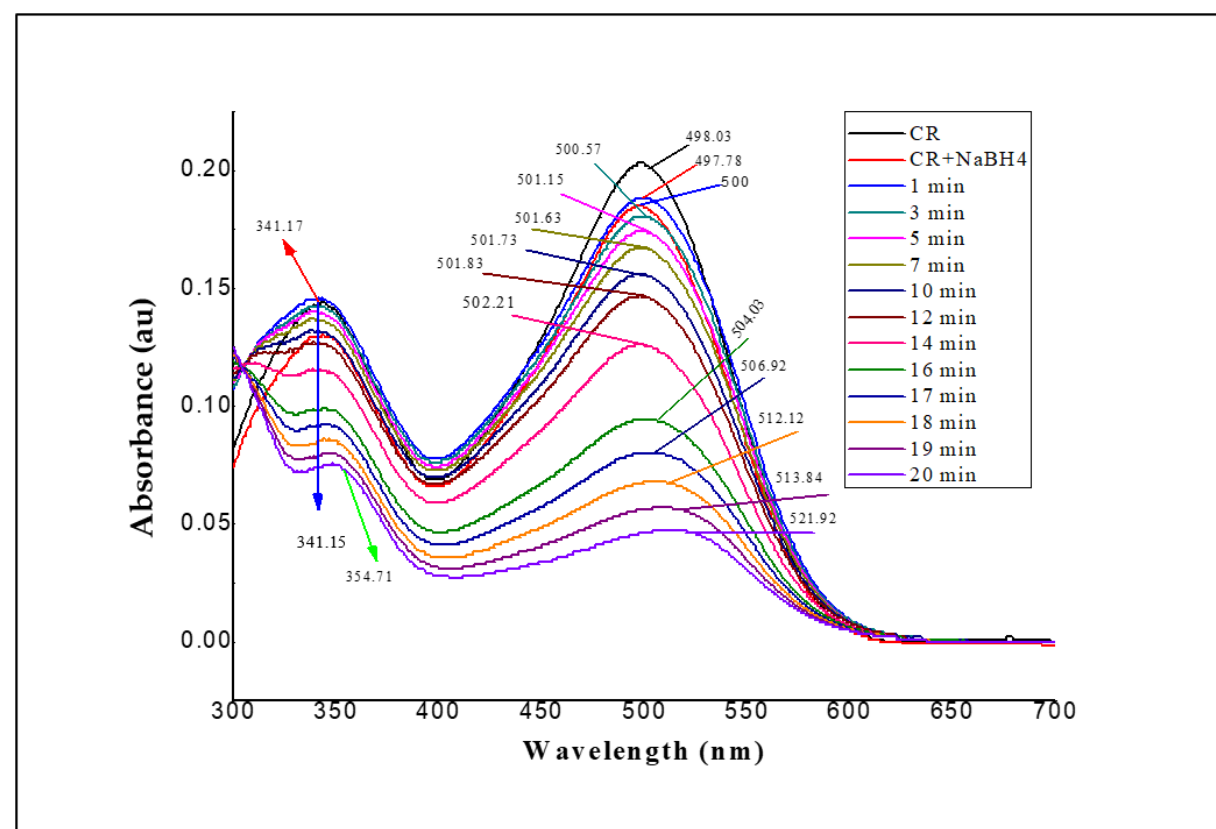
Figure 3. UV-vis spectra of CR, CR+NaBH 4 , and PRO-EPI loaded CR+NaBH 4 , CR control, and CR + NaBH 4 . Control was similar to CR and CR + NaBH 4 (data not shown here).